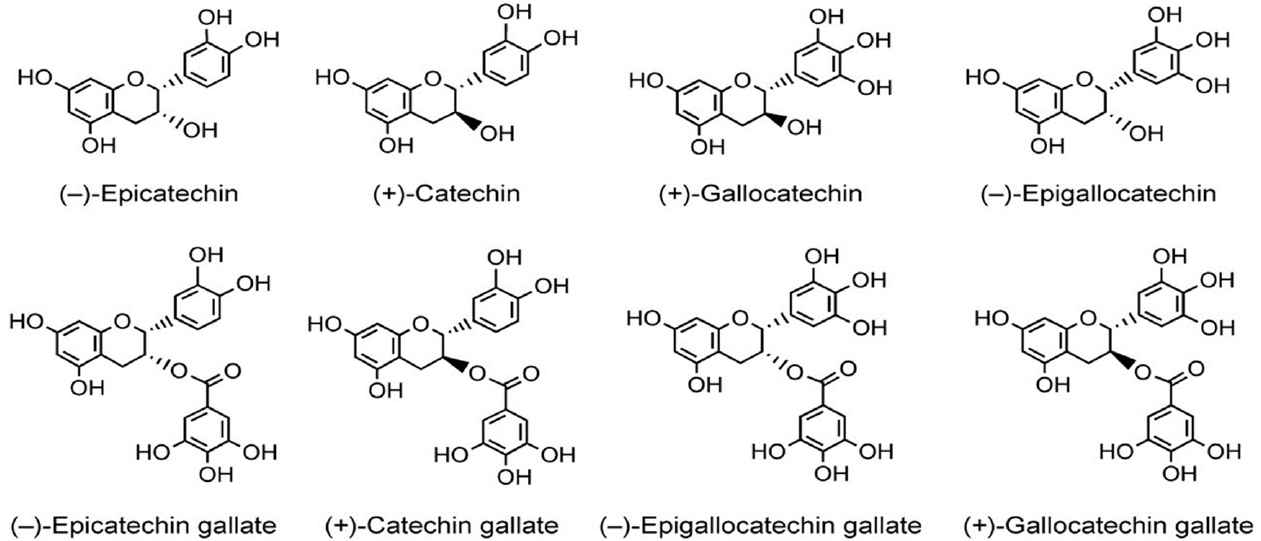
Figure 1. Chemical structure of different green tea catechins.